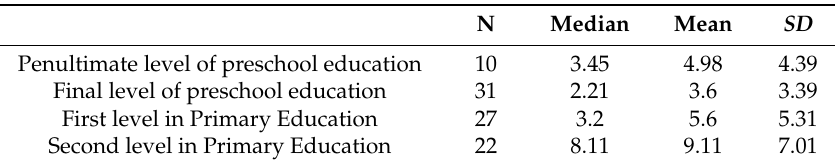
Table 3. Statistical descriptors of the area occupied by the representation of the sun in pictures, split into educational levels.